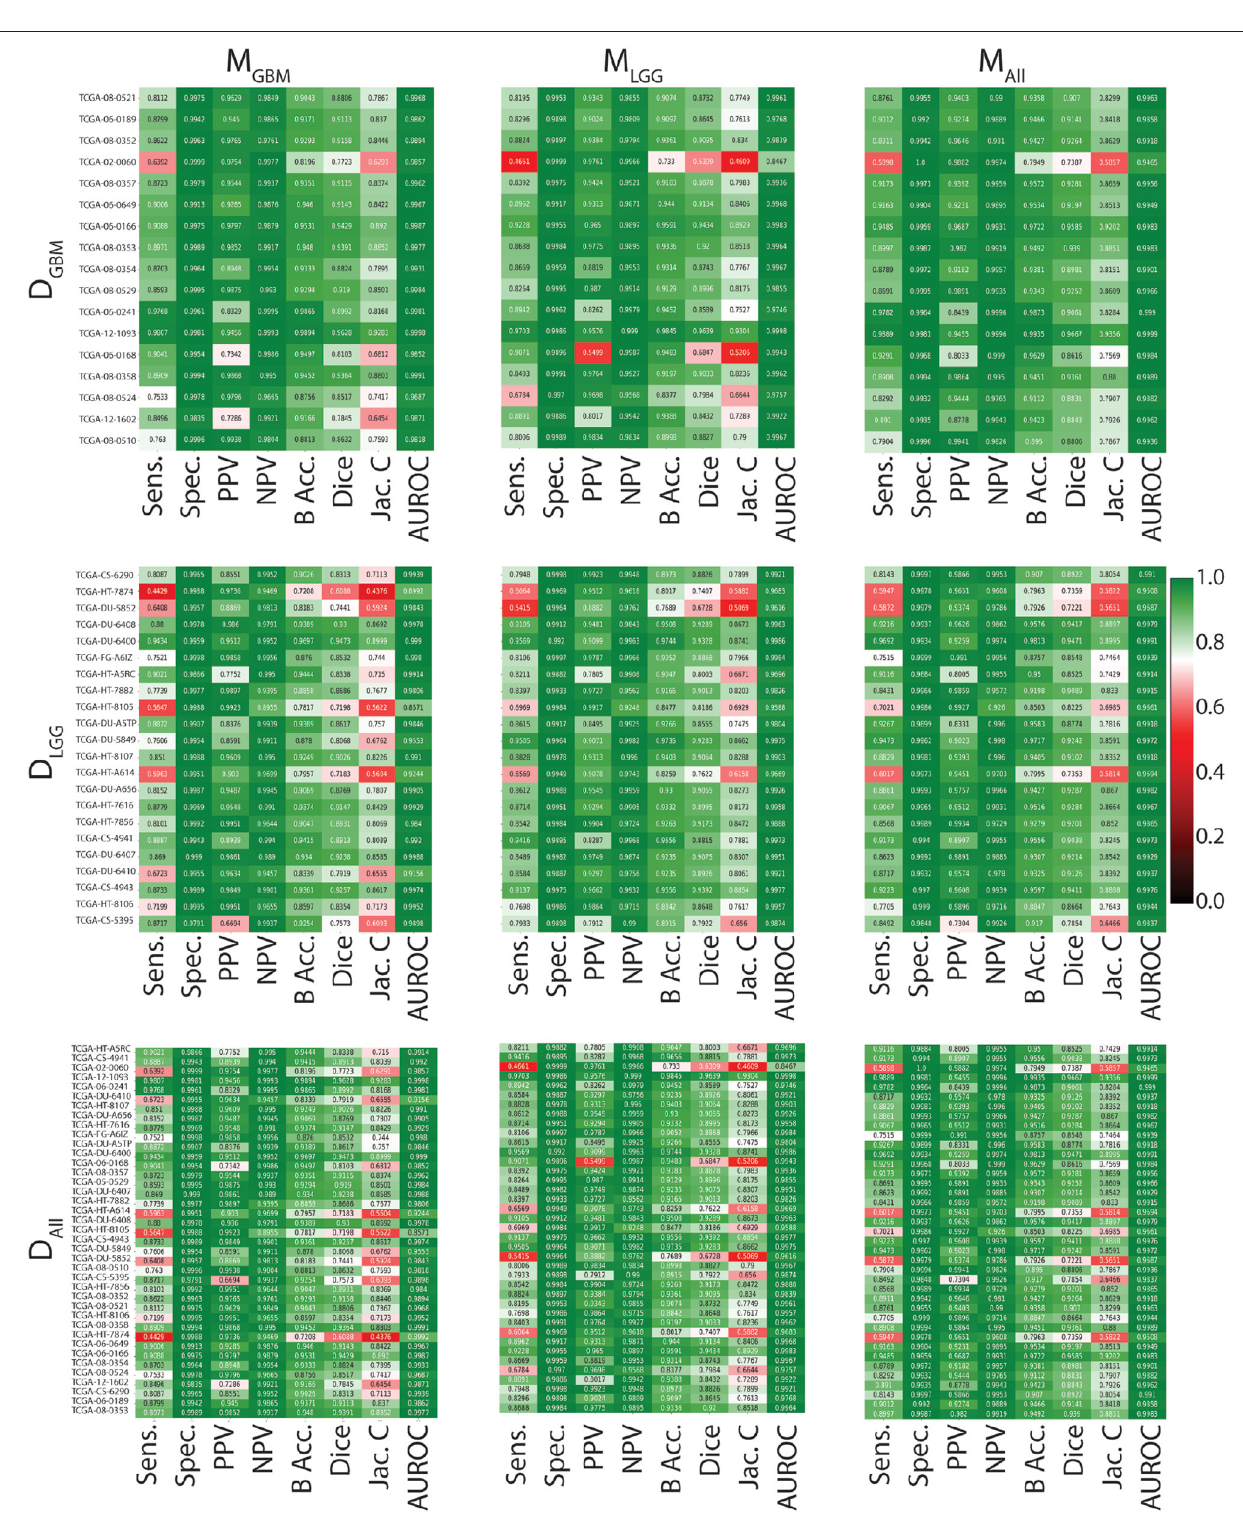
Frontiers in Neuroscience |